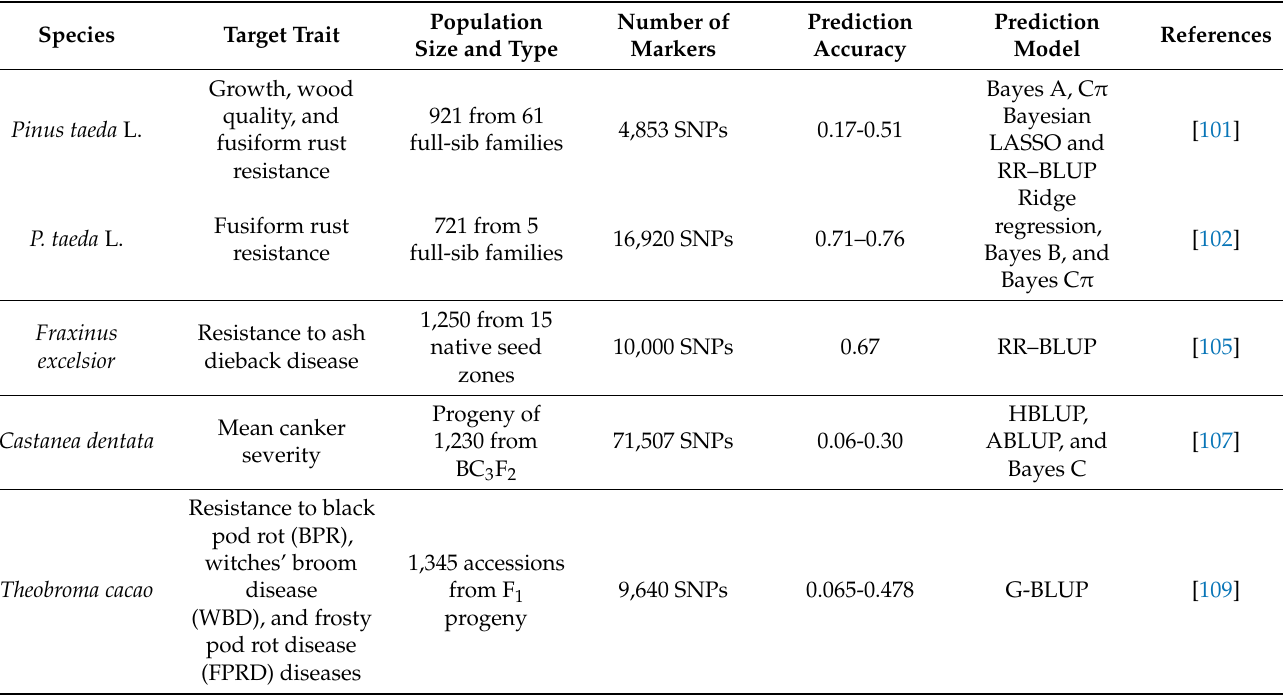
Table 2. GS studies in forest tree breeding applied for disease